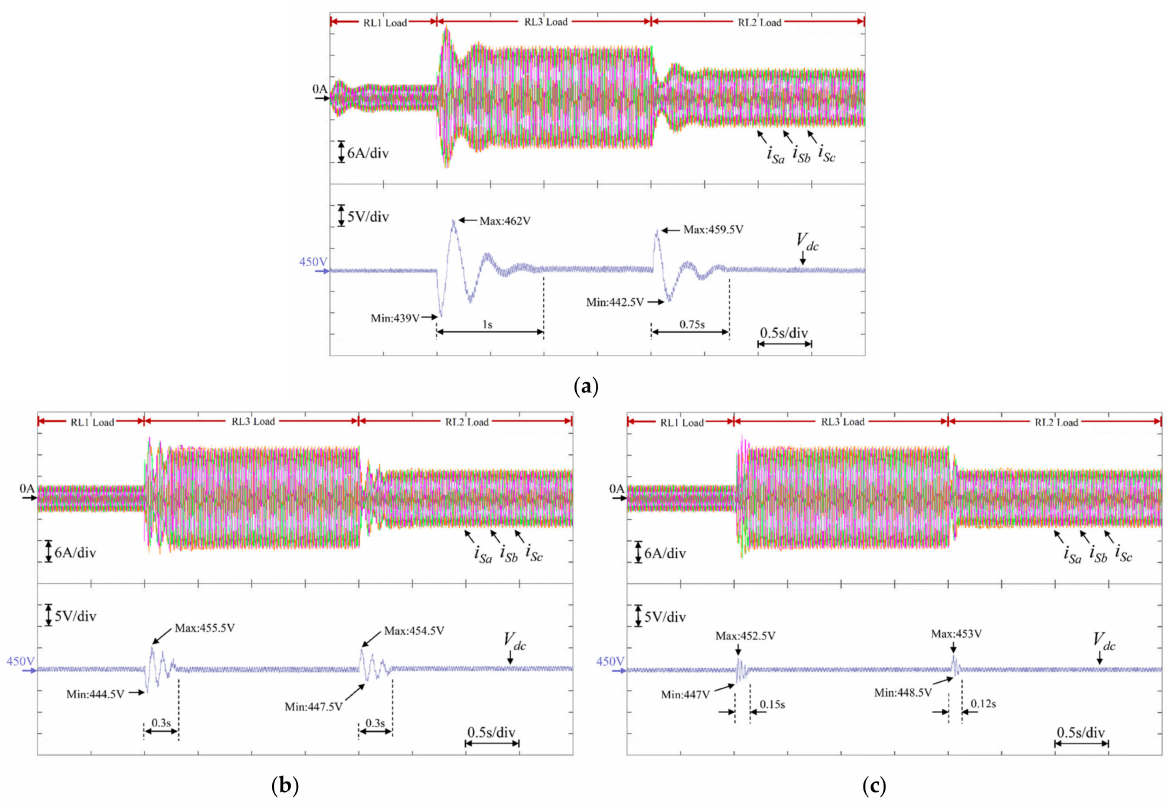
Figure 9. Experimental results under load variation in Case 1. ( a ) Response of grid currents and DC-link voltage of PI-controlled DSTATCOM; ( b ) Response of grid currents and DC-link voltage of FNN-controlled DSTATCOM; and ( c ) Response of grid currents and DC-link voltage of proposed WTSKFNN-controlled